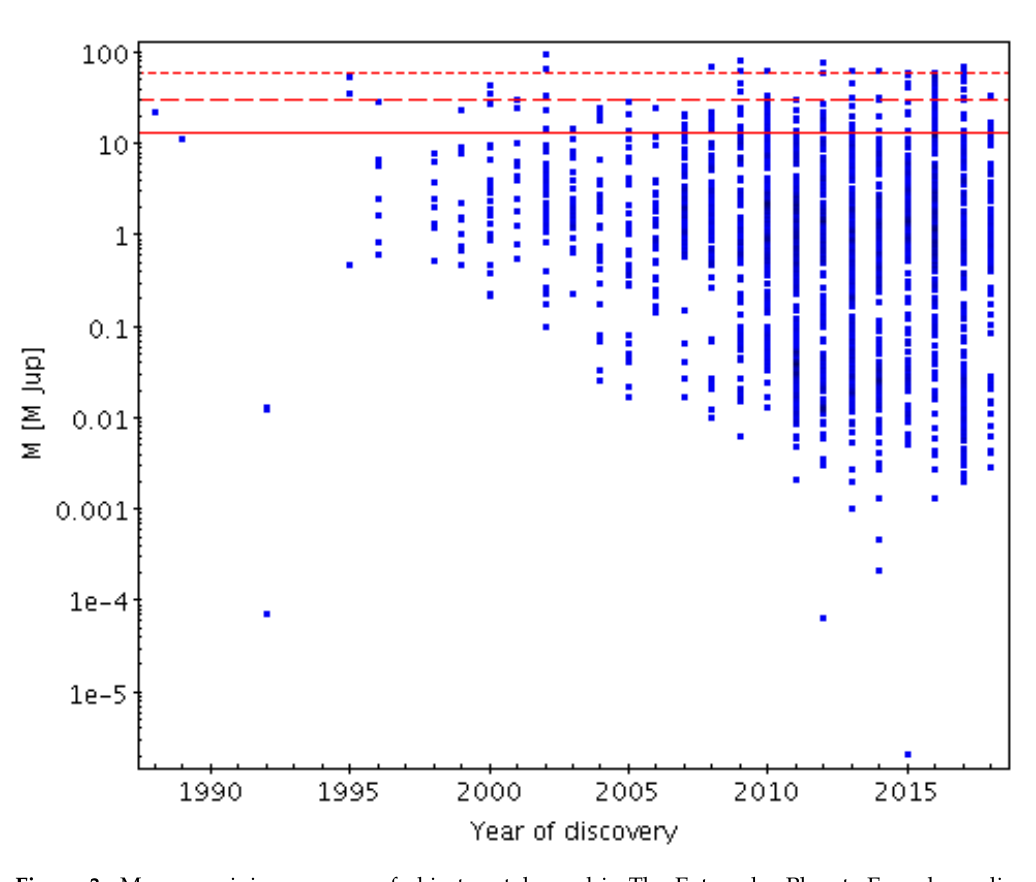
Figure 3. Mass or minimum mass of objects catalogued in The Extrasolar Planets Encyclopaedia as a function of year of discovery until August 2018 [91]. The horizontal lines mark the different Encyclopaedia upper mass limits at 0.060 M sol (dotted), 0.030 M sol (dashed) and 0.013 M sol (solid), from top to bottom. Objects above the solid line (±1 σ ) are brown dwarfs or stars according to the WGESP definition of planet. Below the solid line there are also a few iPMO candidates. Image courtesy of the author.